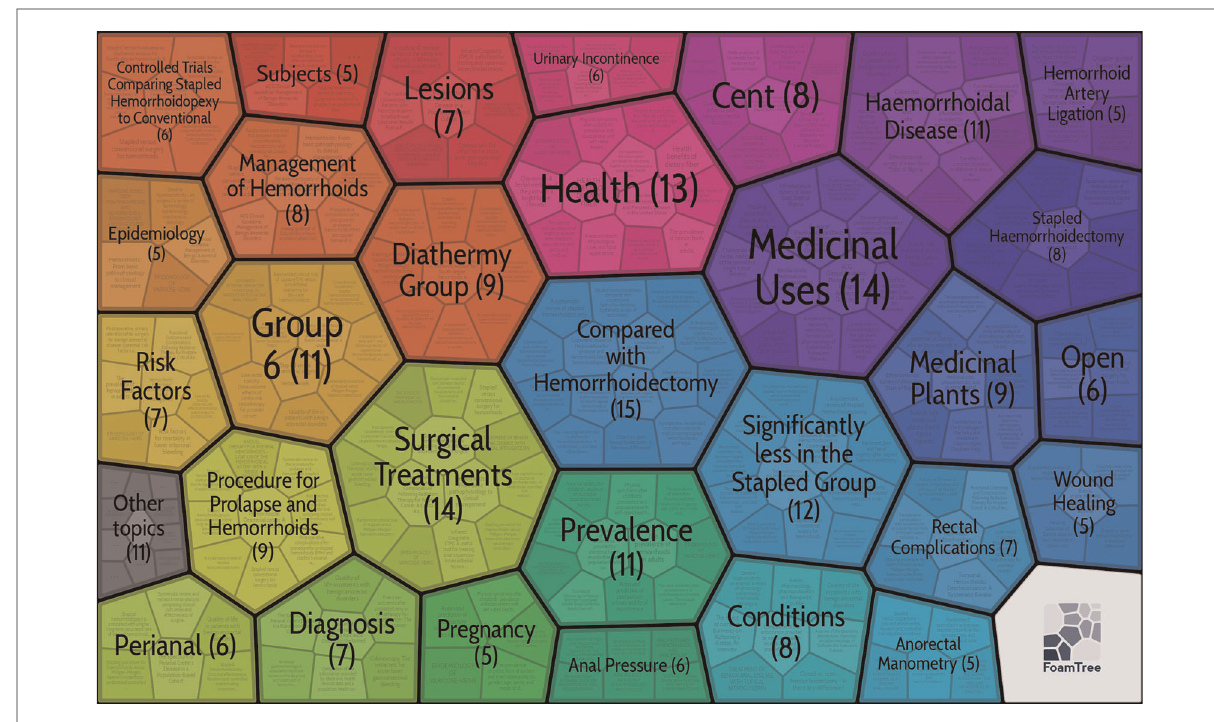
FIGURE 7 30 clustered area diagram formed by the 100 most-cited